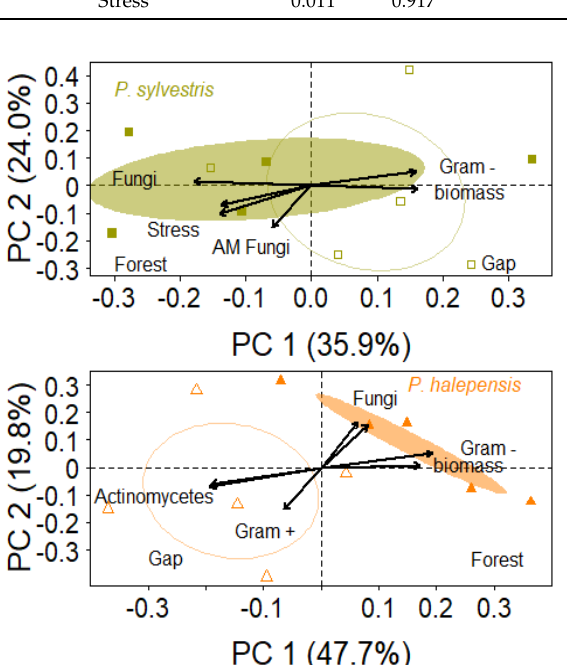
Figure 4. Ordination biplots showing the scores in the first (PC1) and second (PC2) principal components (their variances are indicated between parenthesis) resulting from the analyses of soil samples in the P. sylvestris and P. halepensis stands. Empty and filled symbols correspond to gap and closed-canopy samples, respectively. Arrows represent the main groups of soil microbial community composition.